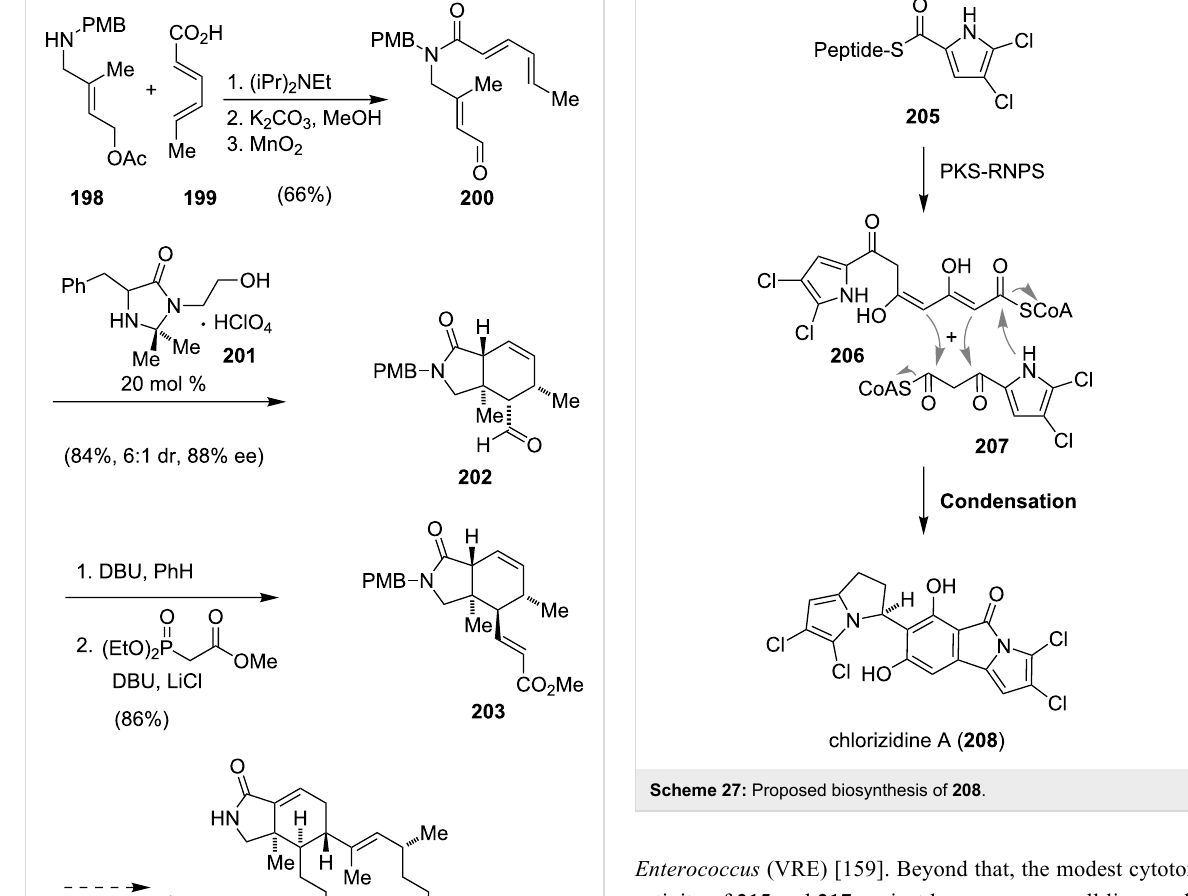
nonribosomal peptide synthetase (NRPS)/polyketide synthase